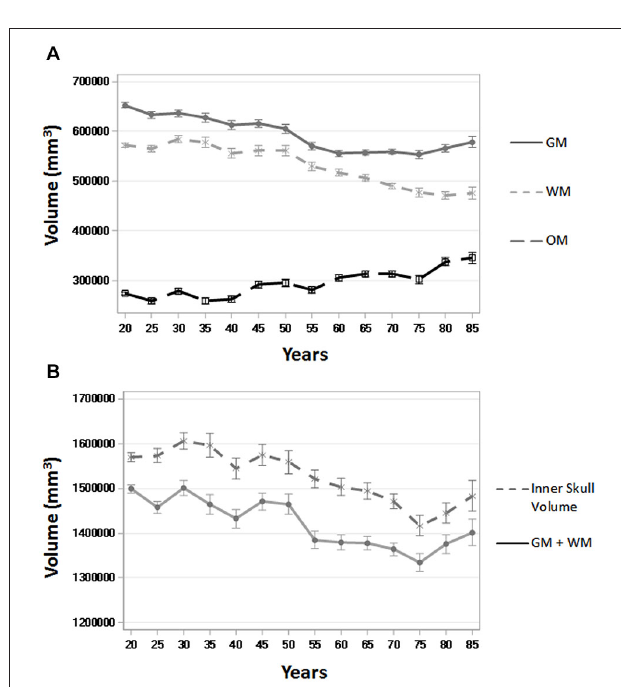
FIGURE 8 | Whole brain tissue and volume measures across age. (A) Gray matter (GM), white matter (WM), and other matter (OM) volumes (in mm 3 ) over five-year age group (all participants) using the PVE based on age-appropriate five-year template priors. (B) GM + WM and inner skull volume (in mm 3 ) over five-year age group (all participants). Inner skull volume was taken from results of the betsurf program. Ticks on each bar represent +/ − one standard